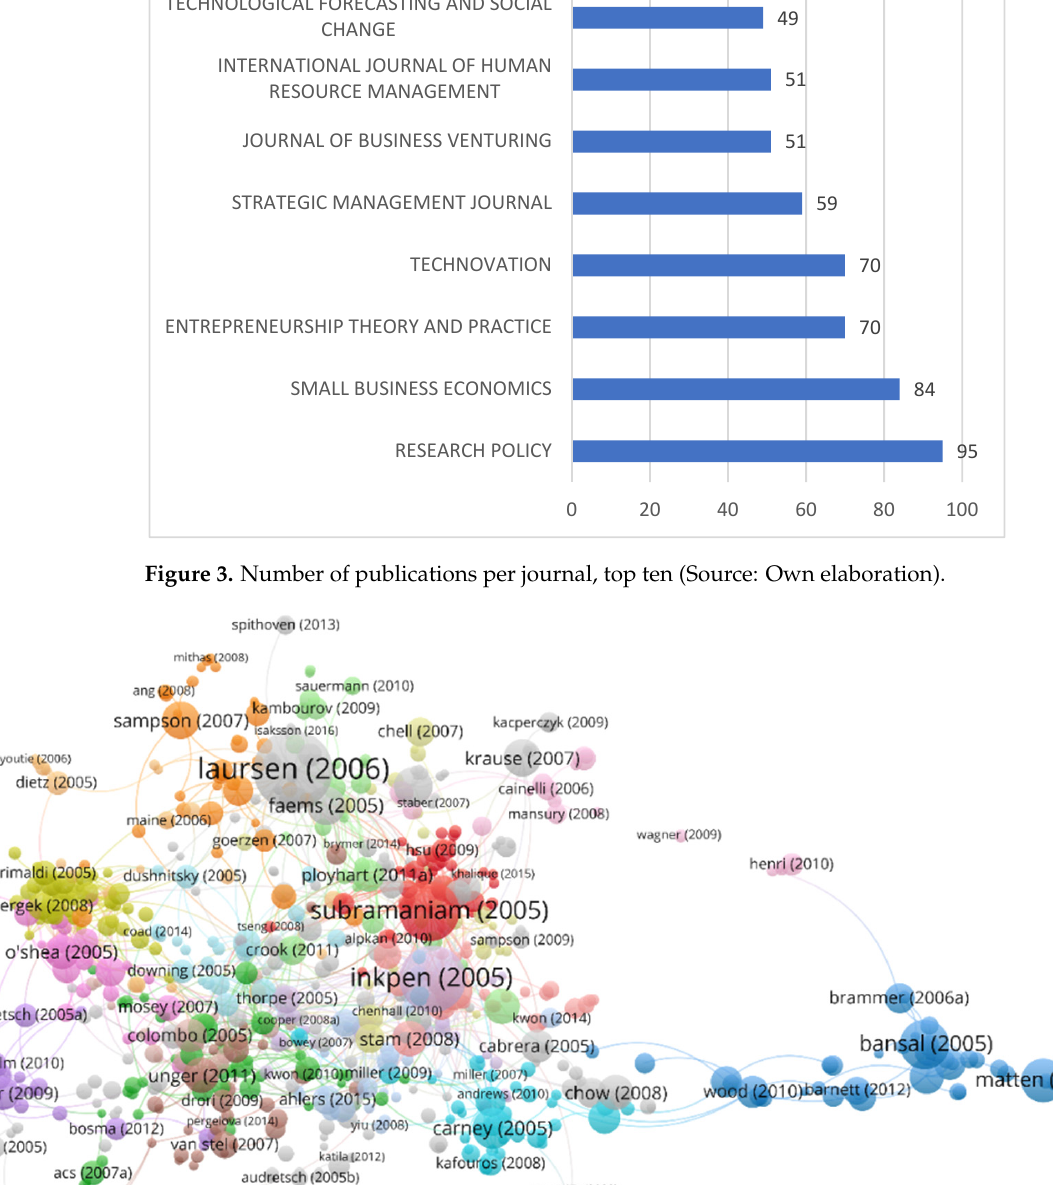
relative importance of the highly cited works (see Figure 4).